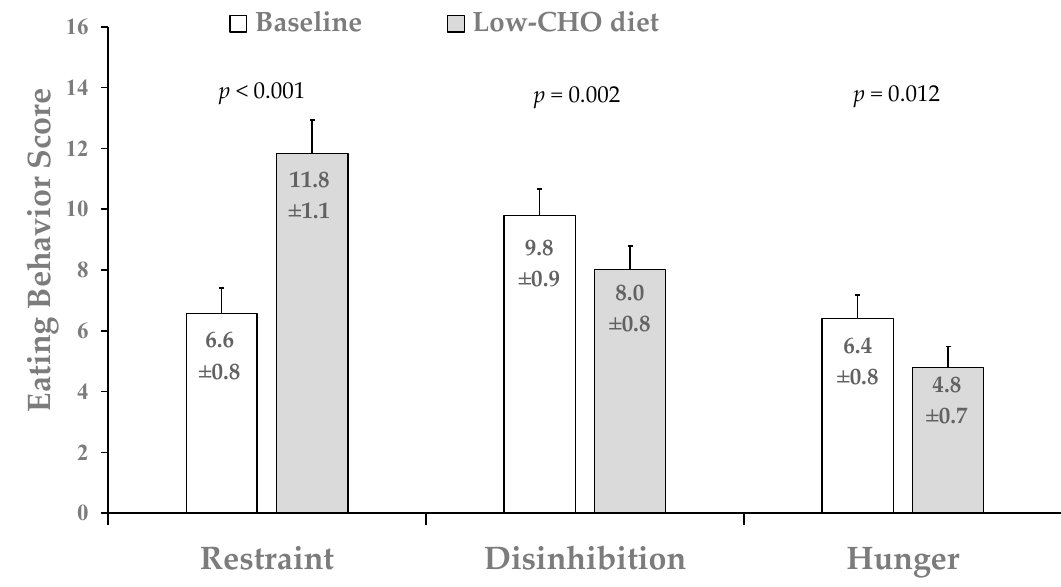
Figure 4. Mean eating behavior scores in the total sample. Data are mean ± SE and reported for N = 18 subjects (9 men and 9 women with complete data for TFEQ). All significance tests were two-tailed.